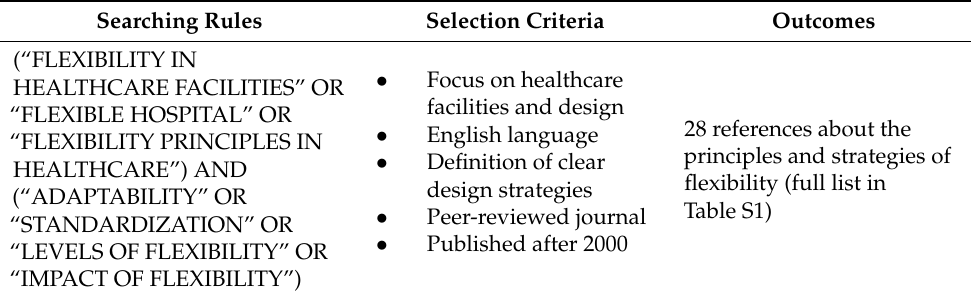
Table 2. Searching rules and selection criteria for review of healthcare design